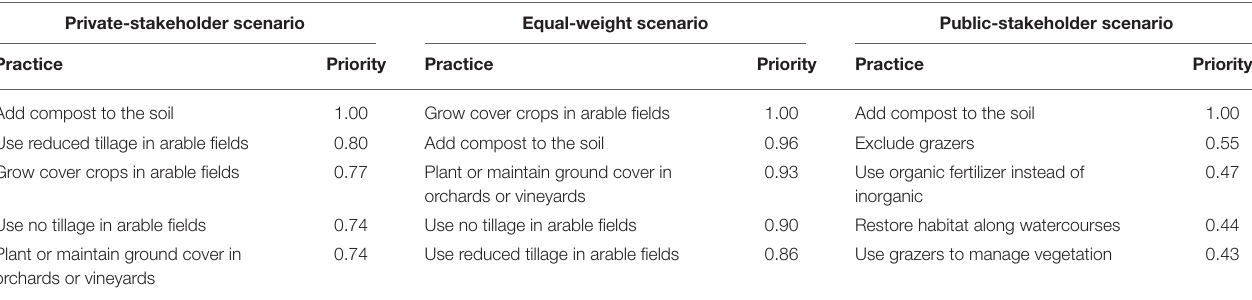
TABLE 4 | Comparison of the five best management practices in three hypothetical